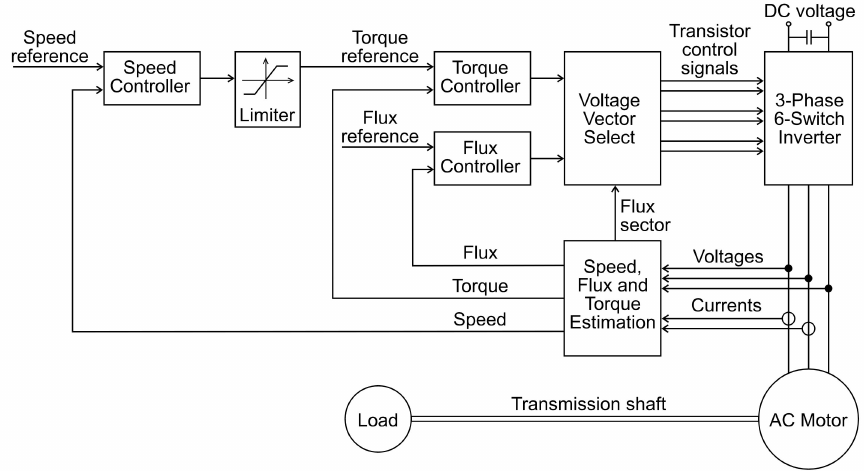
Figure 6. Block diagram of the speed control system of an induction motor containing a long elastic coupling (transmission